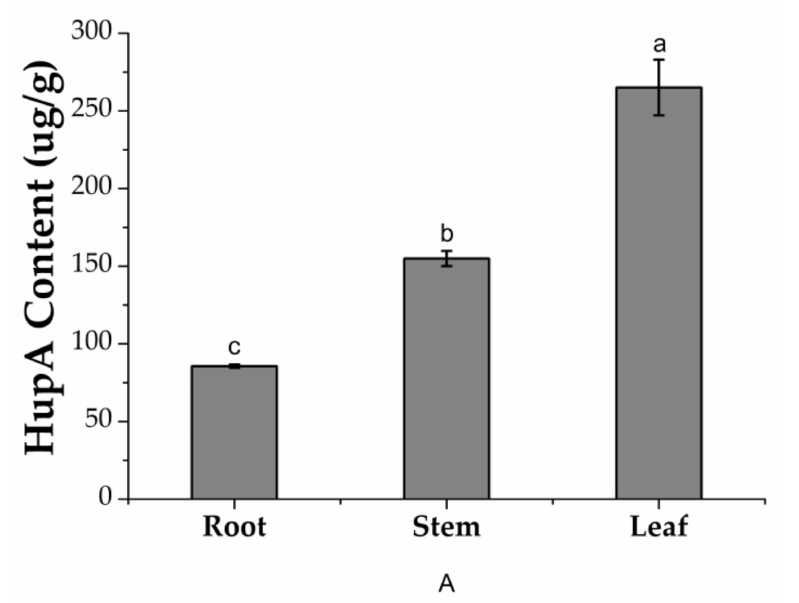
Figure 5. HupA content in different parts including the root, stem, and leaf of H. serrata . Whereas, “a, b and c” are representing the level of significance ( p <